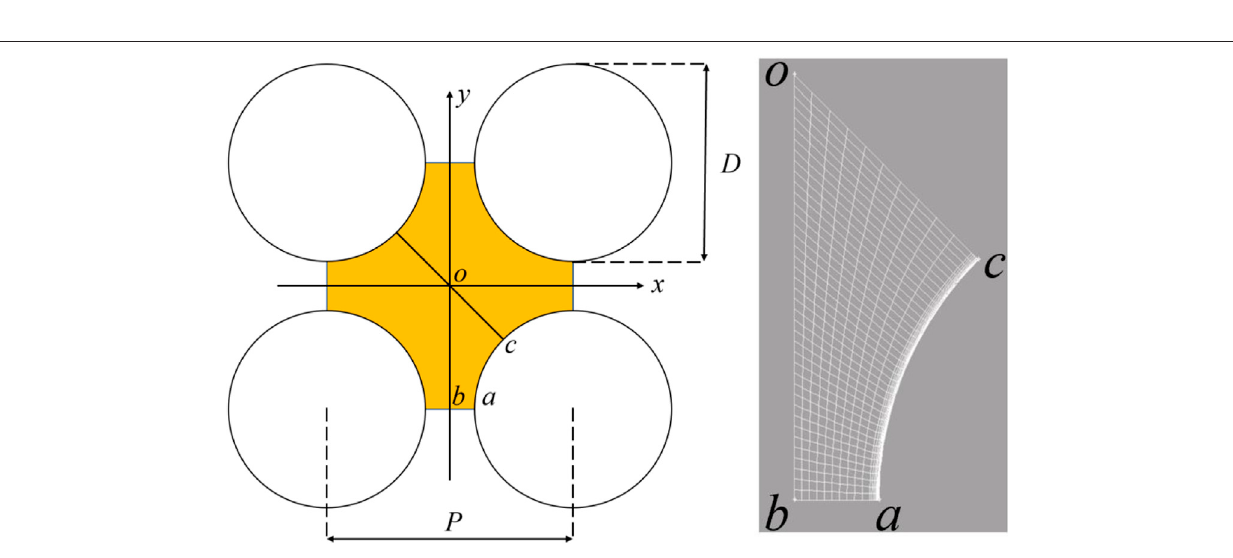
Frontiers in Energy Research |